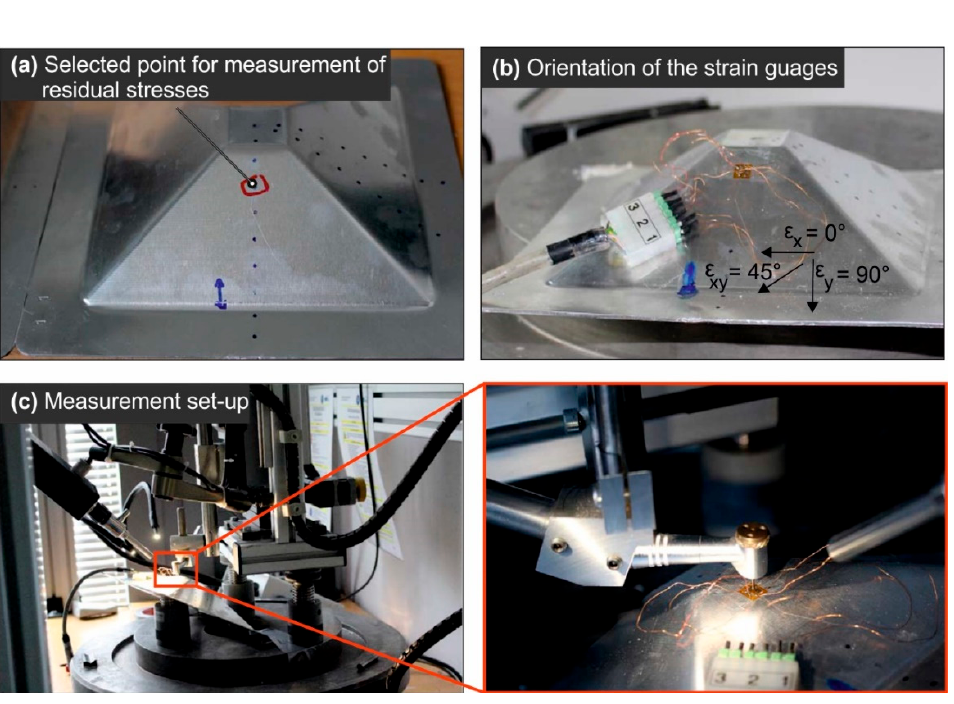
Figure 4. Schematic of the hole-drilling method.